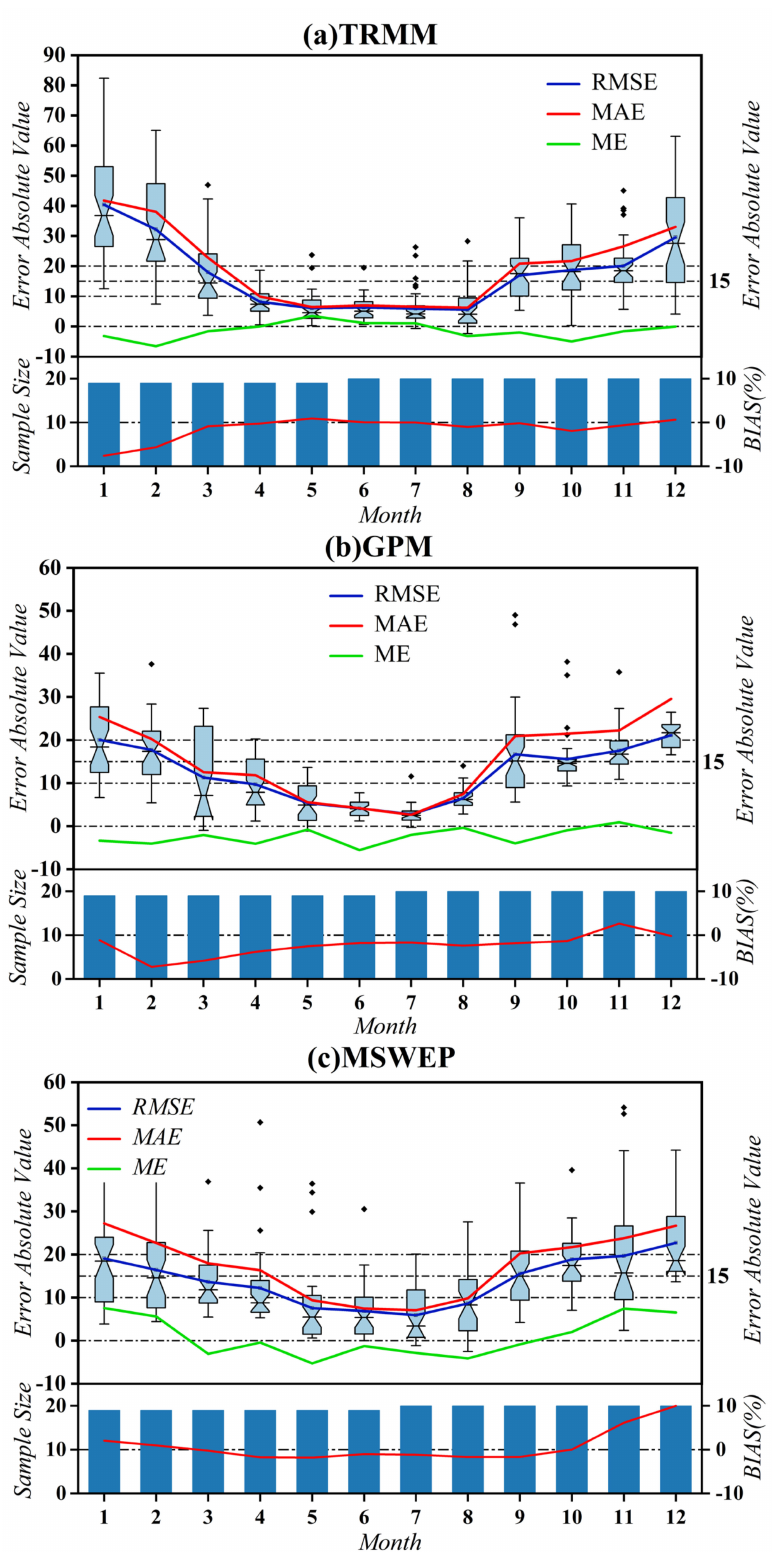
Figure 4. Comprehensive analysis of long-term monthly precipitation error indicators RMSE, MAE, ME and BIAS of ( a ) TRMM, ( b ) GPM and ( c ) MSWEP. In the box plot, the solid black line represents the median value of RMSE, the square represents the average value, respectively, and the black point represents the